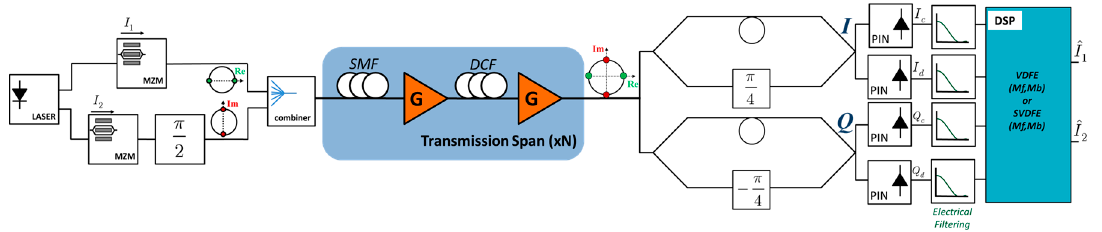
Figure 1. Block diagram of a NRZ-DQPSK set exhibiting N transmission spans and a single wavelength transmitter together with a typical single-ended receiver.